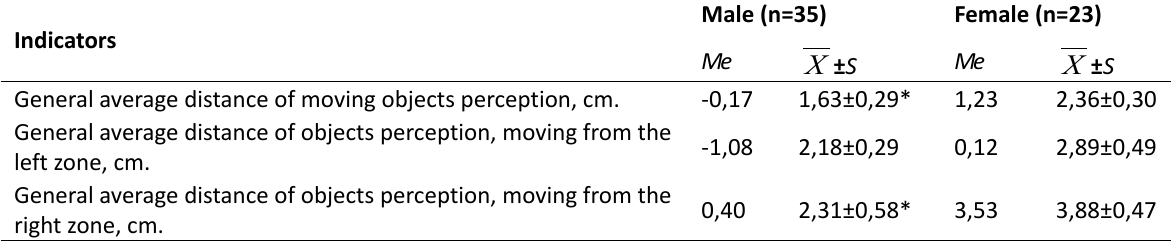
Table 3. Indicators of the reaction to a moving object of basketball players aged 12-13 years during the monocular perception (the right